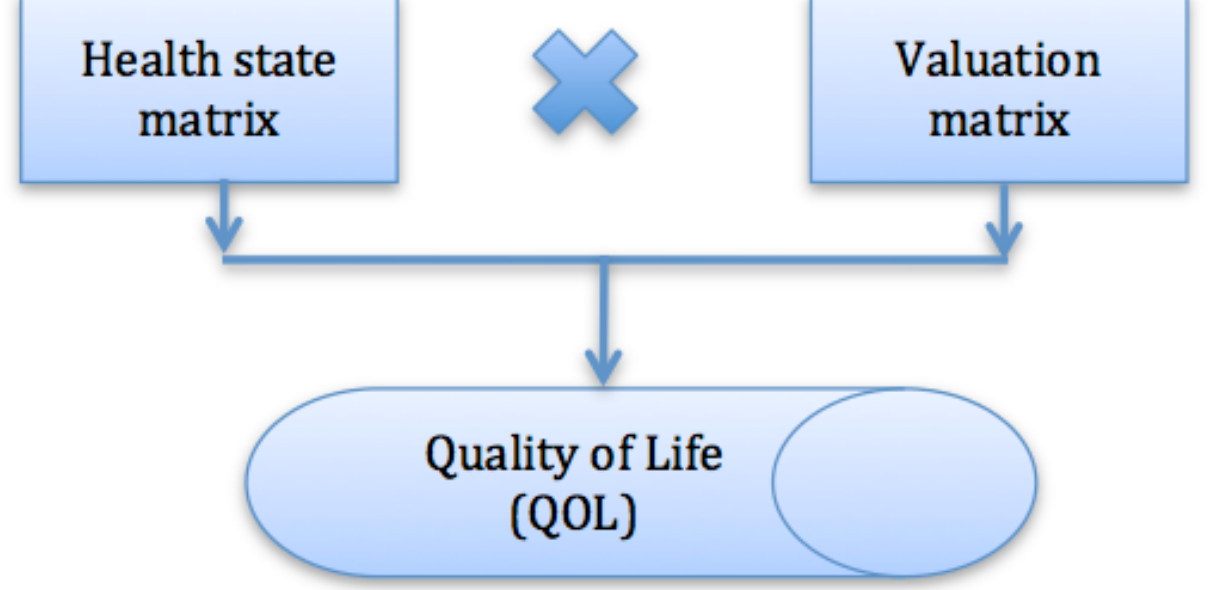
Figure 1. Model for the Rosser Index measuring quality of life (QOL). The health state matrix is based on the Center for Epidemiologic Studies Depression scale (CES-D) scores in relation to the Rosser Disability Category and the Kessler Psychological Distress Scale (K10) scores in relation to the Rosser Distress